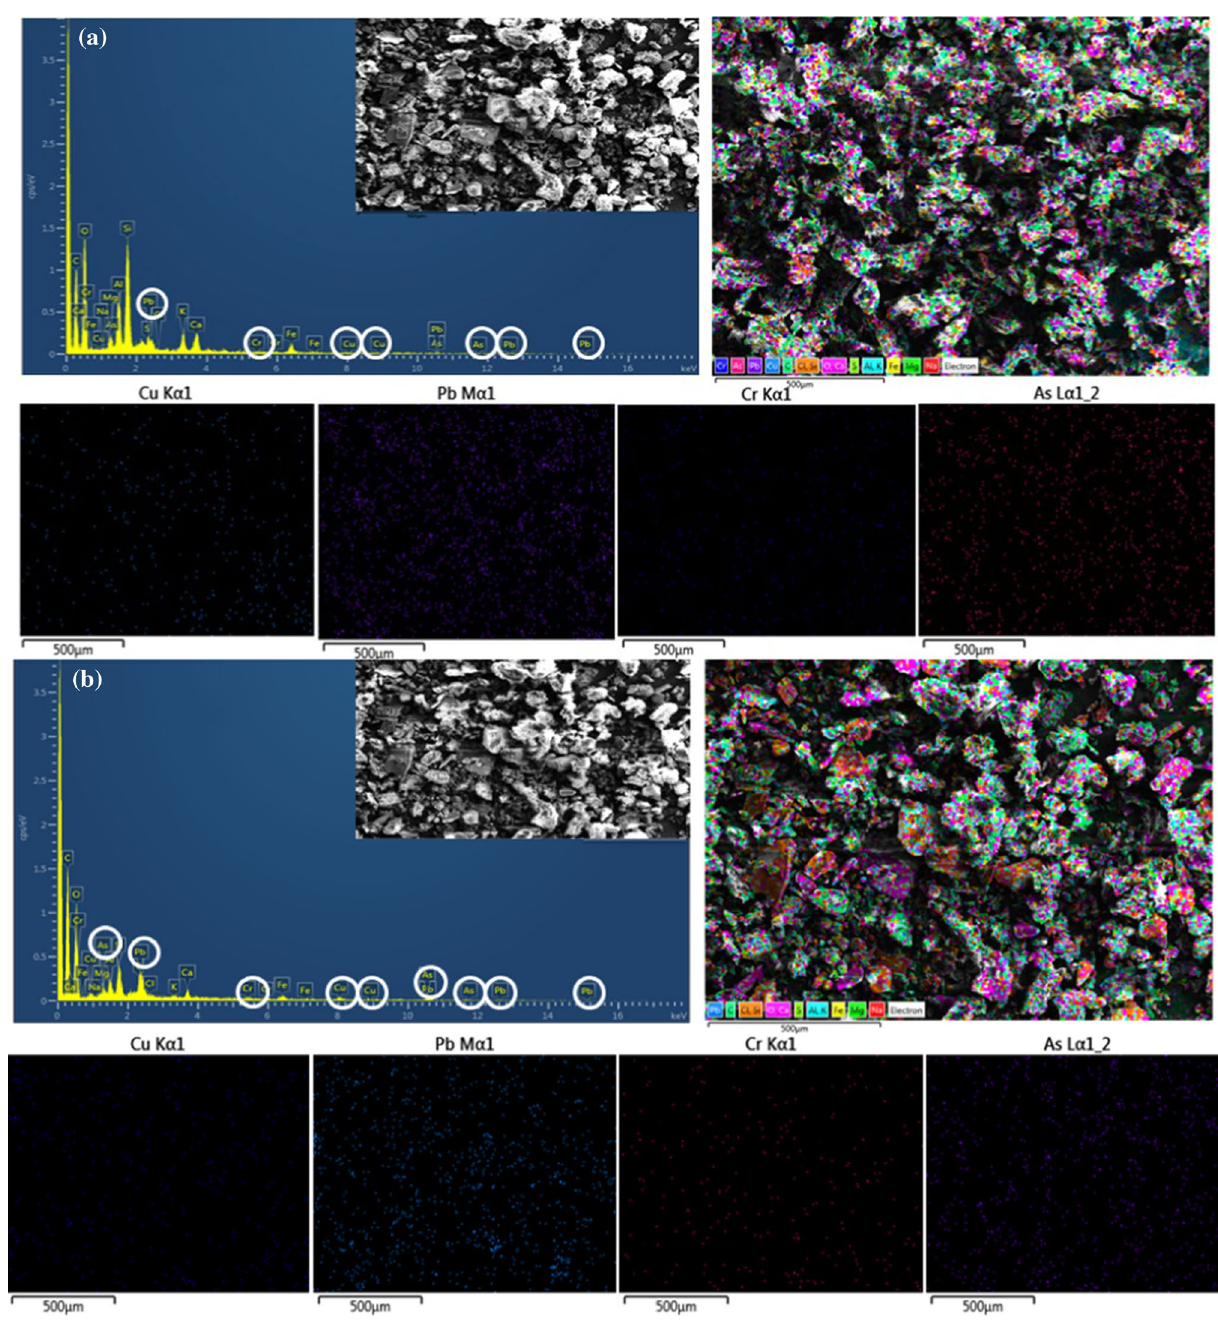
Fig. 2 FESEM micrographs and FESEM-EDX of a Azolla filiculoides and b Hydrilla verticillate , along with metal